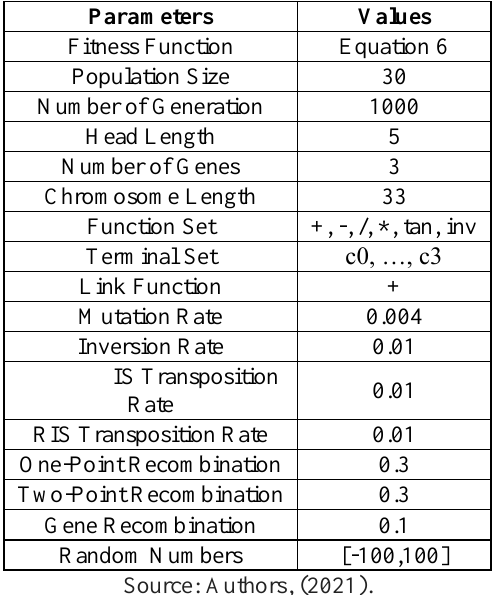
Table 1: Experiment parameters of the GEP model.